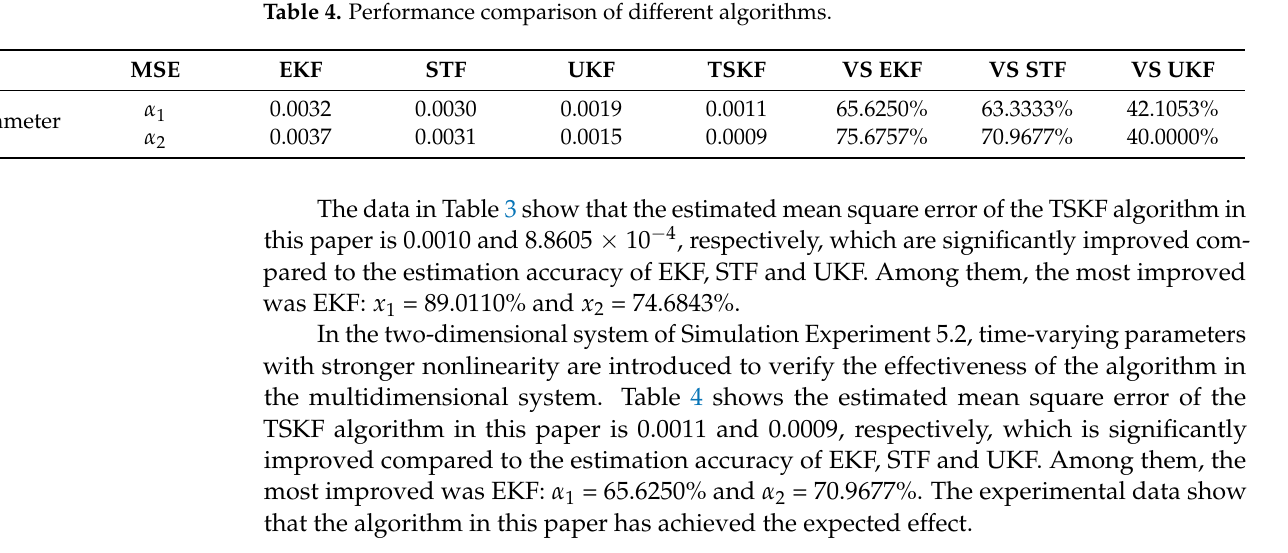
Table 4. Performance comparison of different